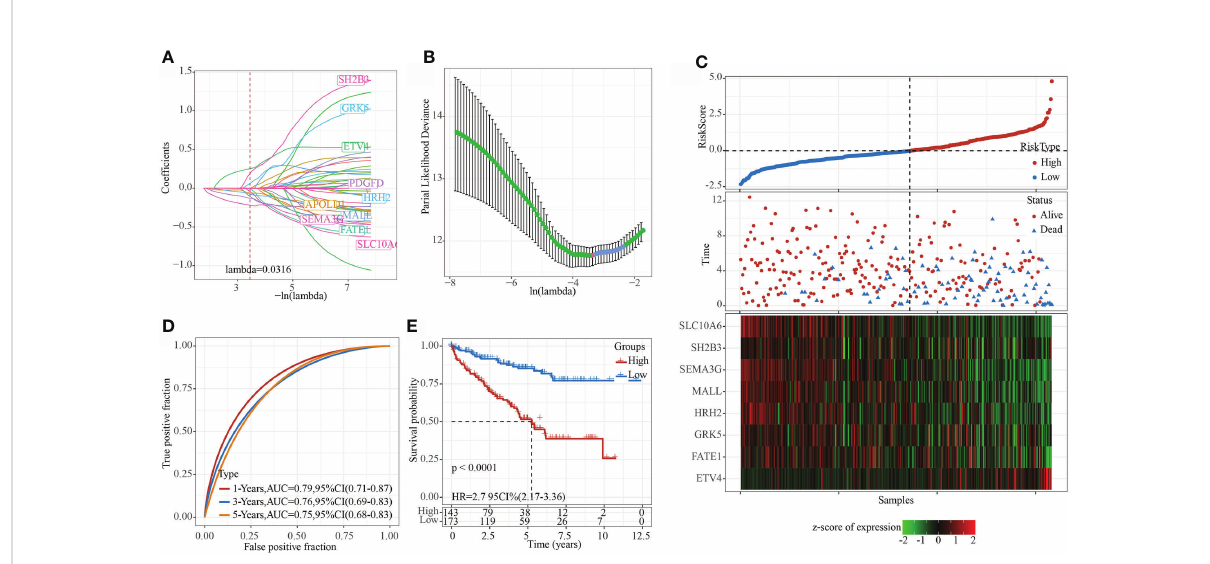
FIGURE 8 Constructing a prognostic model in TCGA data set. (A) The change trajectory of each independent variable, the horizontal axis represents the log value of the independent variable lambda, and the vertical axis represents the coef fi cient of the independent variable; (B) The con fi dence interval under each lambda. (C) RiskScore, survival time and survival status and expression of the 8 genes in the TCGA training set; (D) ROC curve and AUC of 8-gene signature classi fi cation; (E) KM survival curve distribution of the 8-gene signature in the training